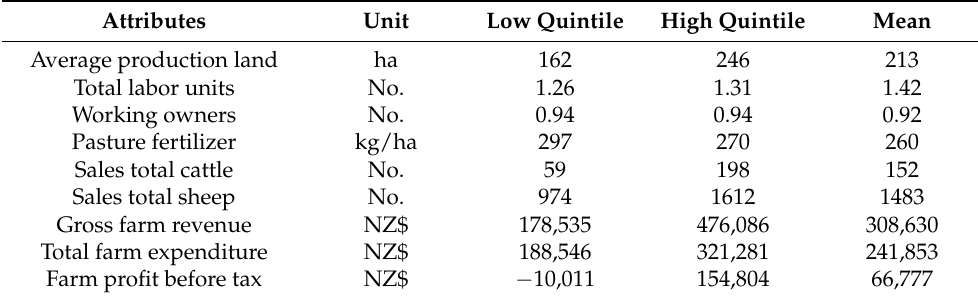
Table 1. Average production land size, total labor units, working owners, pasture fertilizer, average number of sales of beef cattle and sheep, and financial performance of Class 5 North Island intensive finishing Taranaki-Manawatu sheep and beef farm in low and high quintiles and mean of 2018 (quintile analysis ranked by earnings before interest, tax, rent, and manager wage (EBITRm)). Attributes Unit Low Quintile High Quintile Mean Average production land ha 162 246 213 Total labor units No. 1.26 1.31 1.42 Working owners No. 0.94 0.94 0.92 Pasture fertilizer kg/ha 297 270 260 Sales total cattle No. 59 198 152 Sales total sheep No. 974 1612 1483 Gross farm revenue NZ$ 178,535 476,086 308,630 Total farm expenditure NZ$ 188,546 321,281 241,853 Farm profit before tax NZ$ − 10,011 154,804